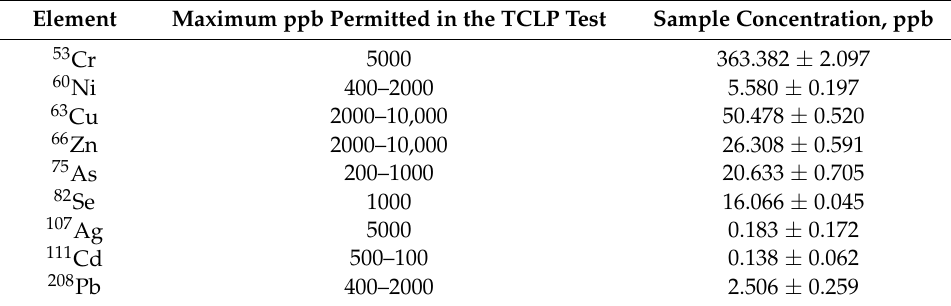
Table 5. Leaching test